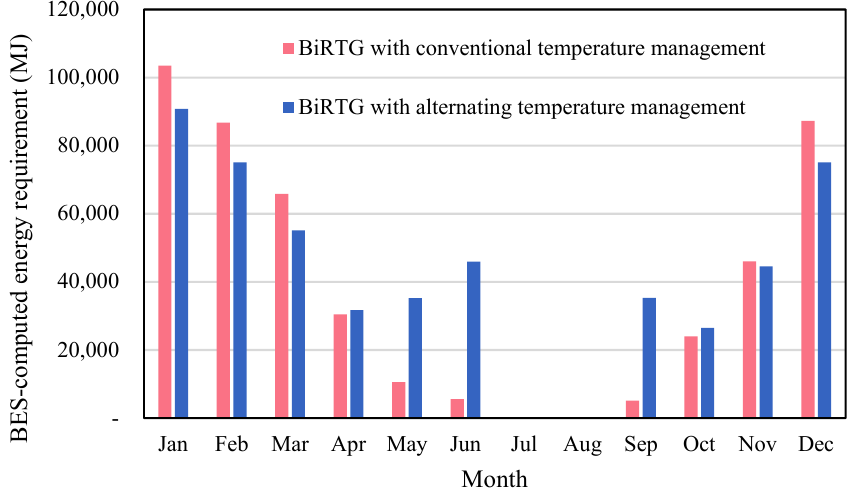
Figure 17. Comparison of monthly energy load of the BiRTG under ATM.